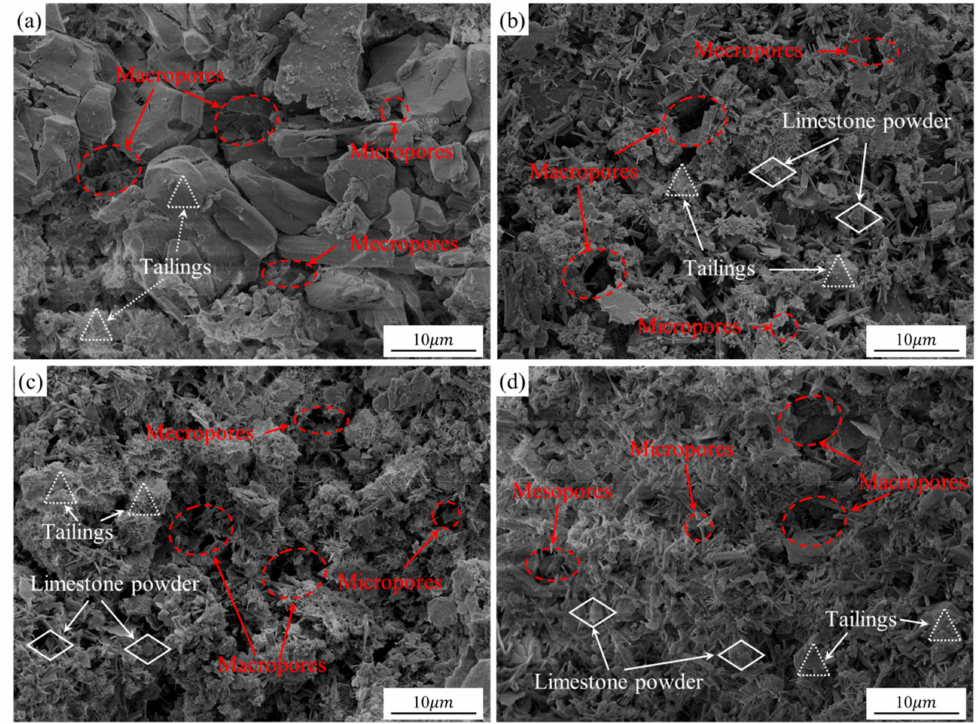
Figure 7. SEM images (5000 × ) of ( a ) B1, ( b ) B2, ( c ) B3, and ( d )